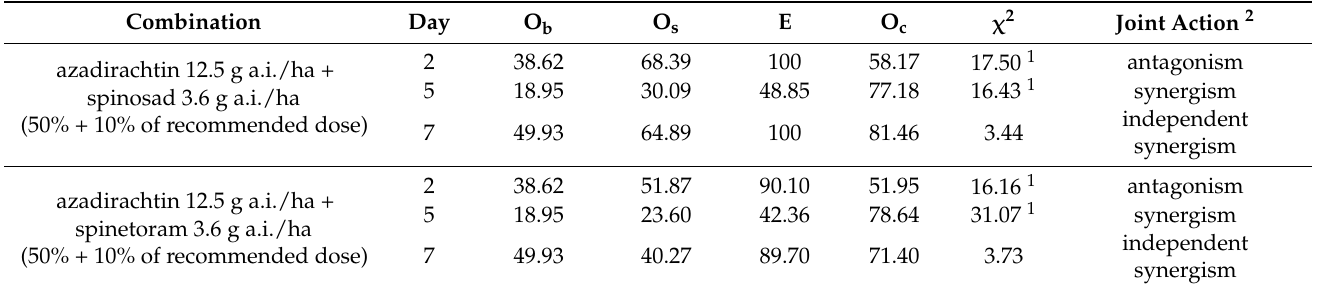
Table 9. Joint action of insecticides on Colorado potato beetle larval mortality determined in the field trial, Zagreb, 2019.